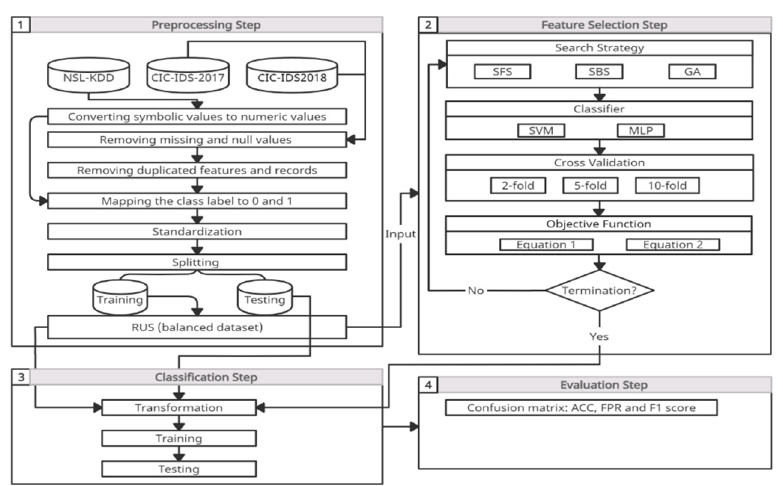
Figure 5. Implementation